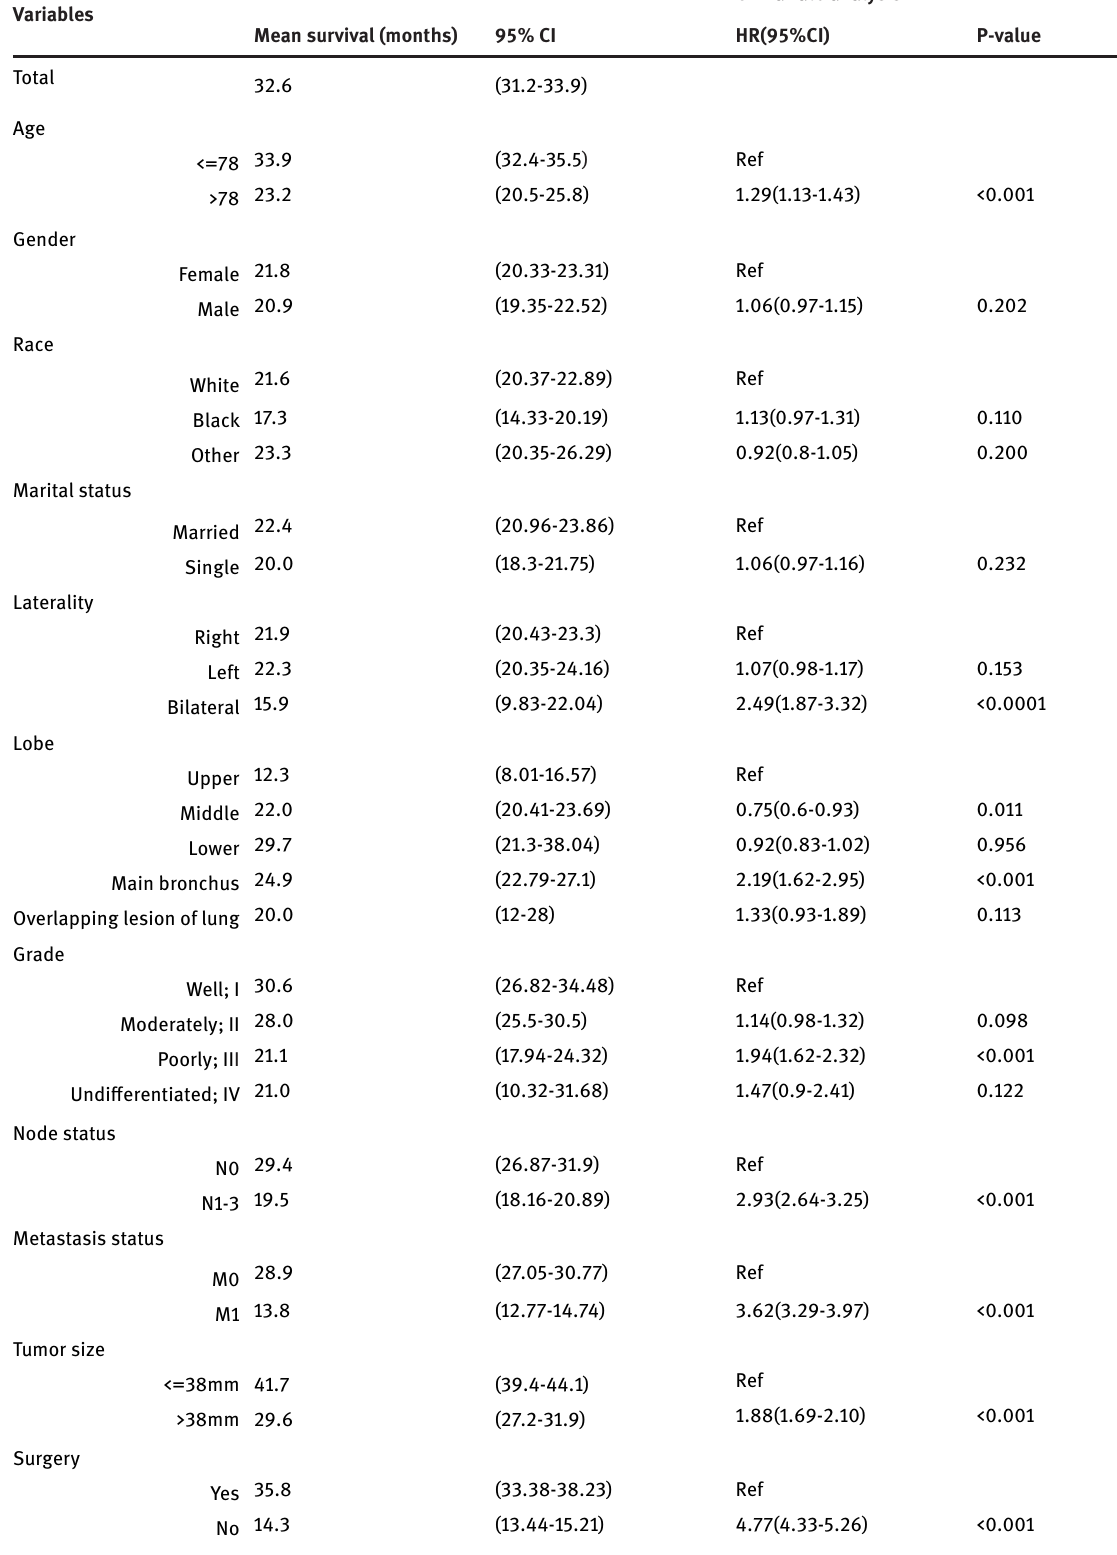
Table 2: Overall survival stratified by clinical characteristics and univariate Cox proportional hazard analyses for patients